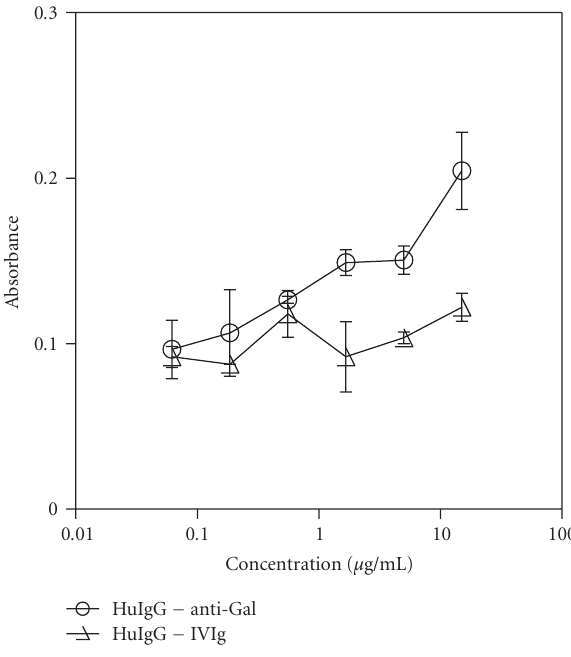
Figure 2: Plates were coated with MUC1 peptide and reactivity of human anti-Gal antibodies were measured. Human IVIg was used as negative control.